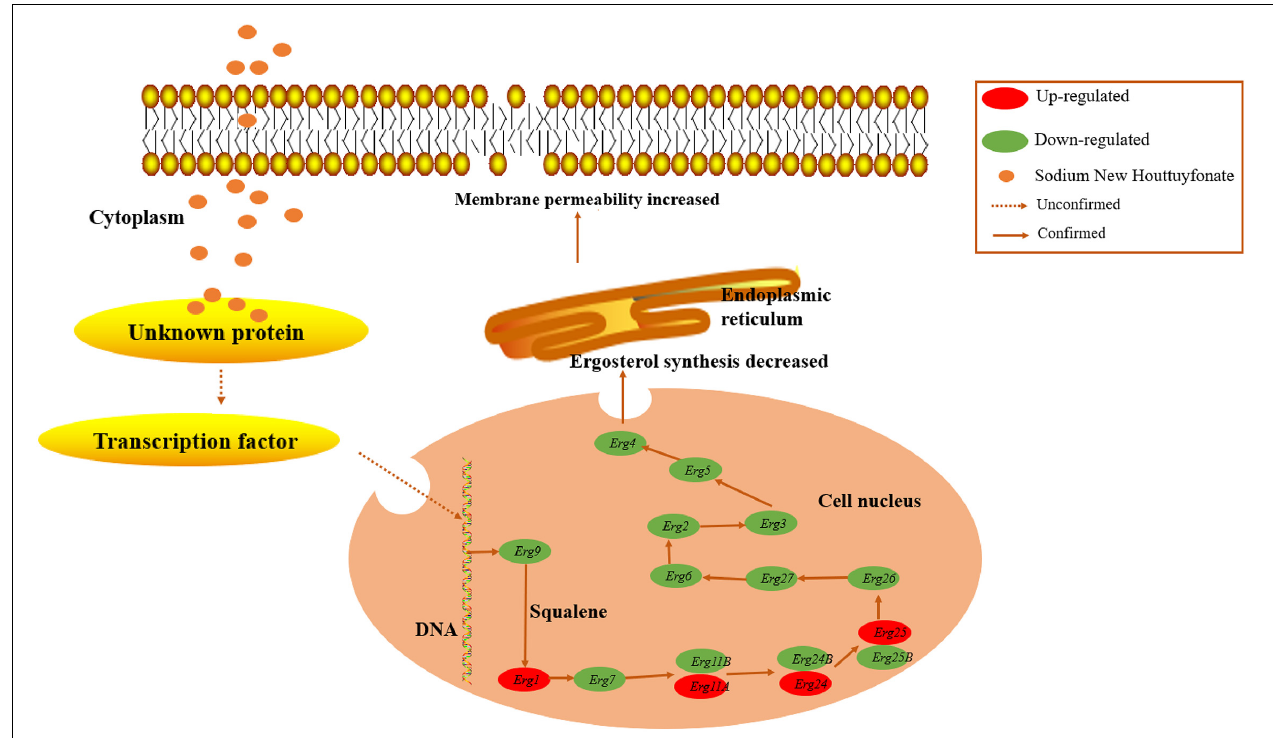
FIGURE 7 | Model of the anti- A. fumigatus mechanism. Sodium new houttuyfonate (SNH) may activate an unknown protein or transcription factor, which translocates to the nucleus and inhibits ergosterol synthesis in the endoplasmic reticulum via suppressing the expression of related genes in A. fumigatus . The cell membrane permeability is elevated, thus contributing to cell growth inhibition or death. Dotted arrows indicate unknown pathways, and solid arrows indicate verified pathways.